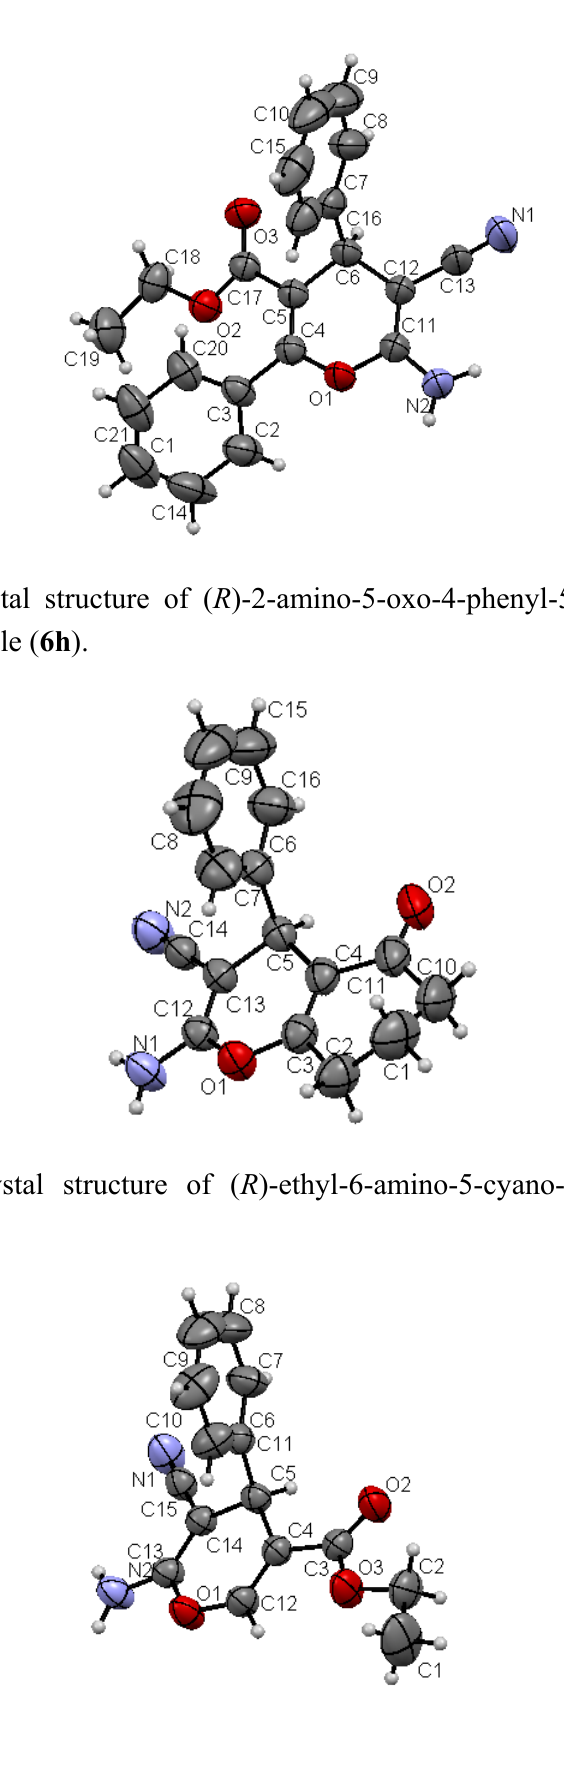
Figure 4. X-ray crystal structure of ( S )-ethyl 6-amino-5-cyano-2,4-diphenyl-4 H -pyran-3- carboxylate ( 6e ).